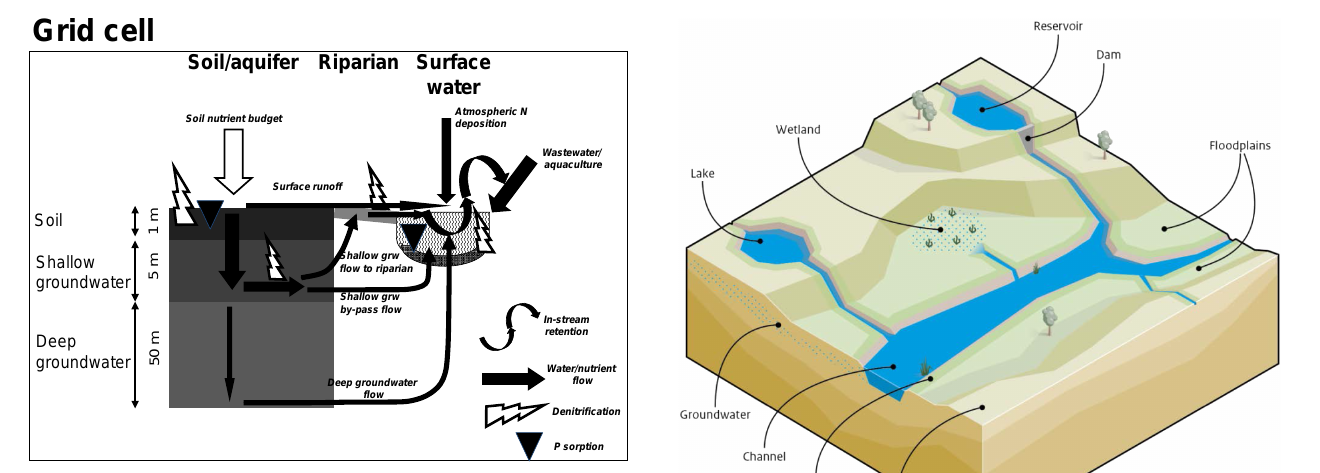
Figure 3. Scheme of the flows of water and nutrients, and retention processes within a grid cell.